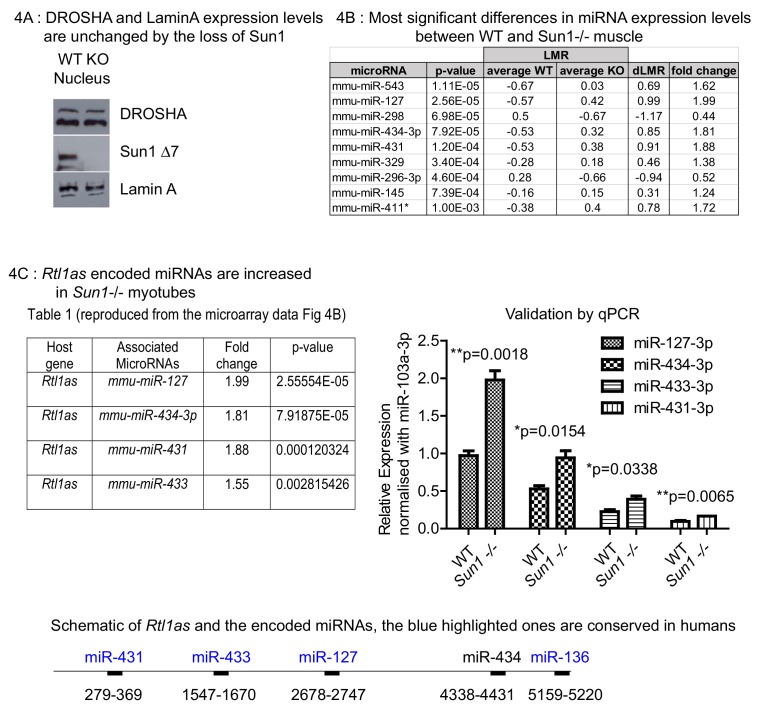
Effect of Sun1 loss on DROSHA expression and on the regenerating myofibre miRNA profile.(A) Equal Drosha and Lamin A protein levels were present in the nuclear fractions from Sun1–/– and WT myotube cultures. WT and Sun1–/– primary myoblasts were differentiated into myotubes and then processed into cytoplasmic and nuclear fractions. Sun1 Δ7 antibody was the control for the WT lysate, Lamin A antibody was the positive control for the nuclear fraction. (B) Table lists the miRNAs that show significant fold differences in expression levels between WT and Sun1–/– myotubes. The p-values are based on the t-test. The top five miRNAs pass the Bonferroni correction for multiple testing (0.000161). Average expression (LMR) are shown for both groups, including the difference (dLMR) and the conversion into fold change. (C) The four miRNAs are all encoded by the Rtl1as transcript (see underlying schematic of the Rtl1as transcript and the position of the miRNAs). These miRNAs were expressed at significantly higher levels in Sun1–/– myotube cultures compared to WT cultures (4C Right panel). The relative abundance of each miRNA is also shown – (miR-127–3p>miR-434–3 p>miR-433–3p>miR431-3 p) and was determined by the CT values (qRT-PCR).